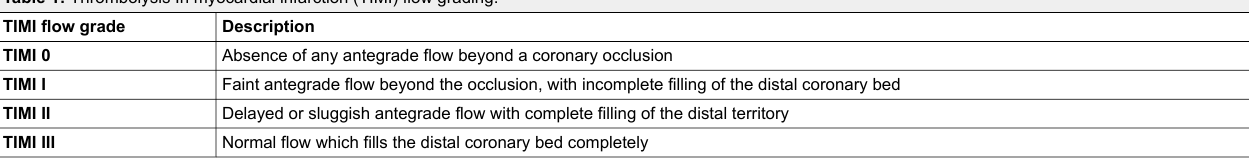
Table 2: Myocardial blush grading